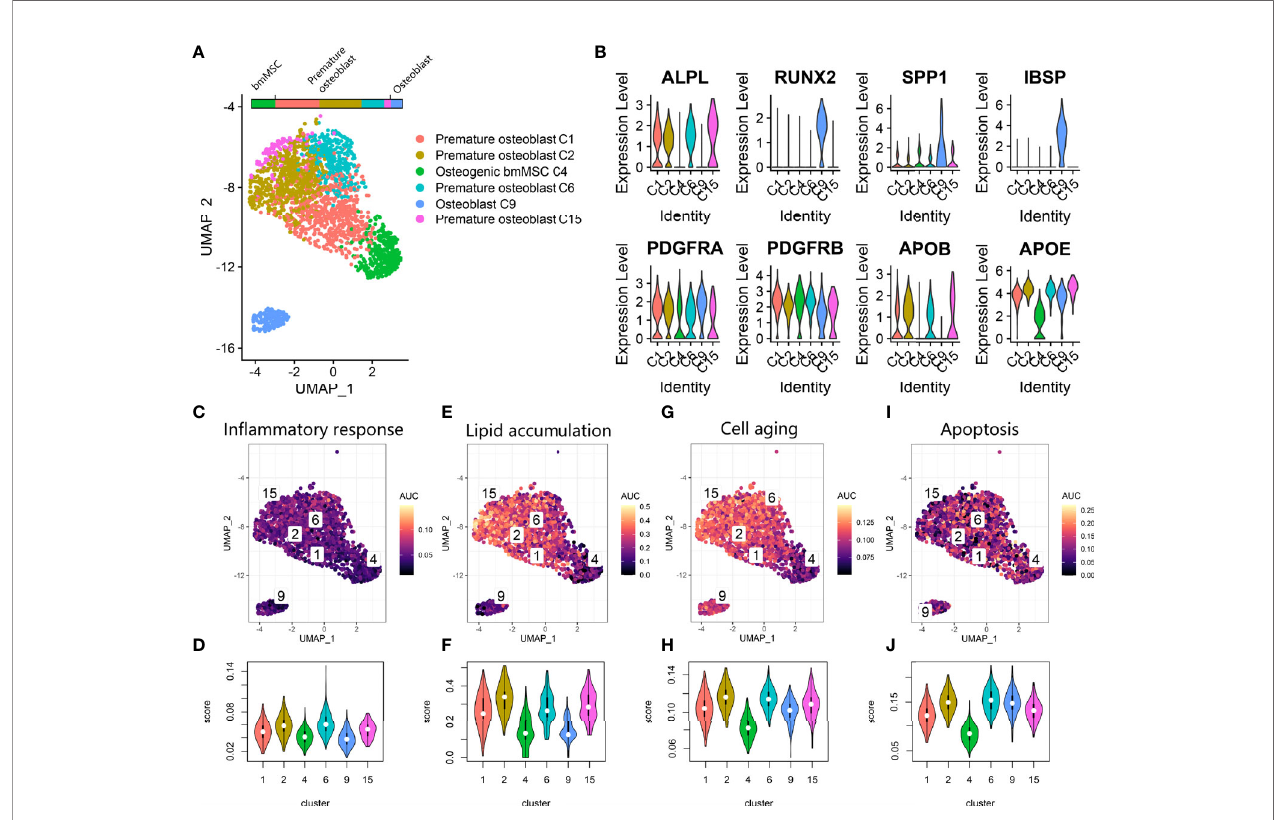
FIGURE 3 | Osteoblast lineage expression in osteoporosis. (A) UMAP plot showing osteoblast lineage clusters. (B) Violin plot for the osteogenic gene (ALPL, RUNX2, SPP1, IBSP) and fat cell differentiation gene (PDGFRA, PDGFRB, APOB, APOE) expression markers in osteoblast lineage clusters. (C, E, G, I). Scatter plot showing the distribution of AUCell scores of gene sets, including in fl ammatory response (C) , lipid accumulation (E) , cell aging (G) and apoptosis (I) , in the osteoblast lineage. Yellow indicates a high score, and purple indicates a low score. (D, F, H, J) Violin plots exhibiting the AUCell scores of gene sets including in fl ammatory response (D) , lipid accumulation (F) , cell aging (H) and apoptosis (J) in the osteoblast